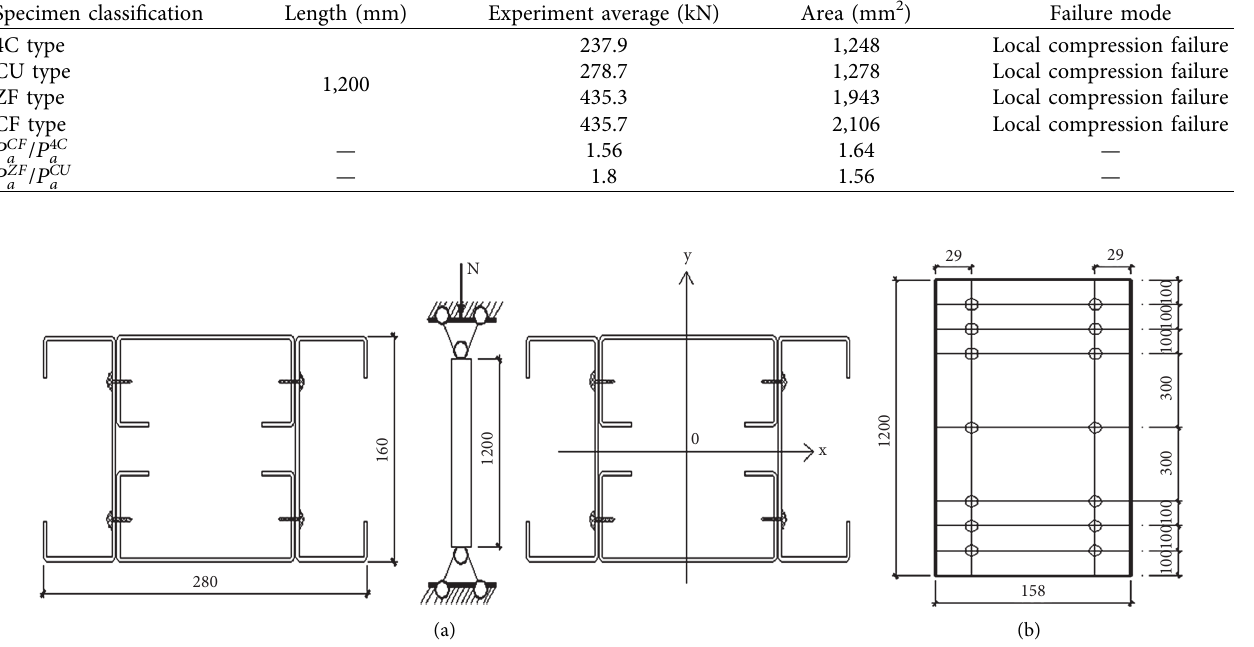
Figure 27: 4C-type section: (a) calculation diagram and (b) screw distribution.